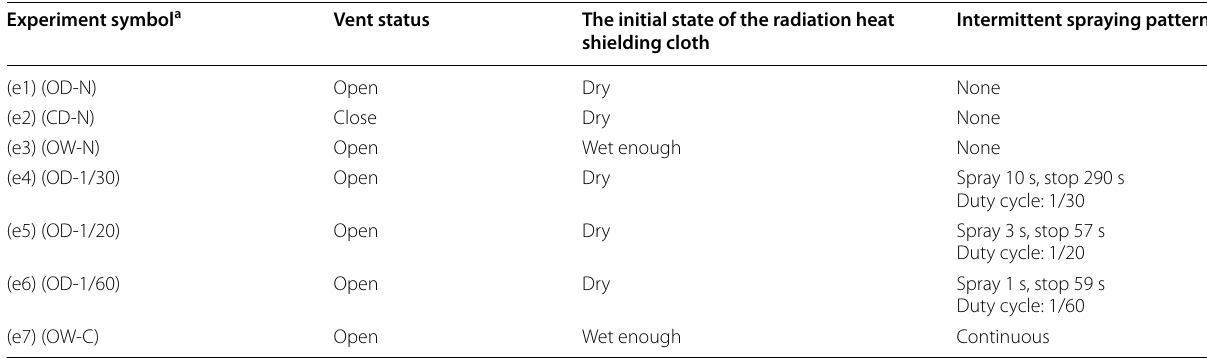
Table 4 Experimental conditions for radiative heat